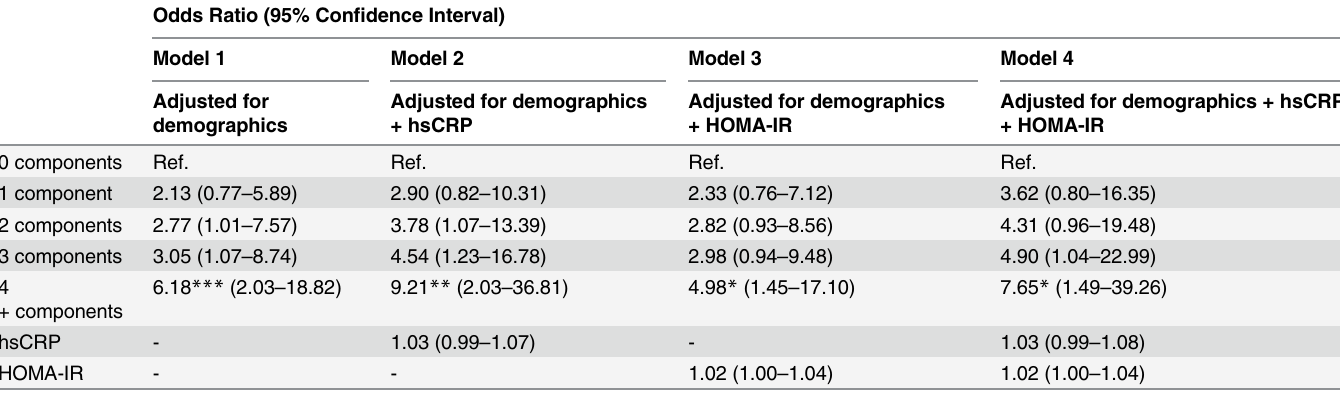
Table 4. Odds ratios for chronic kidney disease predicted by number of components of the metabolic syndrome with adjustments as described